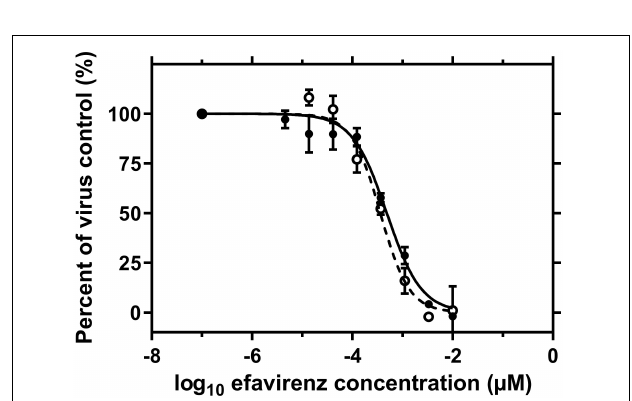
FIGURE 3 | No influence of the graphene ink on the dose-dependent antiviral activity of efavirenz in a cell-based HIV replication assay. An 8-point half-logarithmic serial dilution of efavirenz, starting from 0.01 µ M, was preincubated for 24 h with (a solid line) or without (a dashed line) graphene ink on PET-foil before use in a standard antiviral assay. The preincubation of efavirenz with graphene did not change the EC50 value of approximately 0.4 nM nor the overall characteristics of the dose-response curve. Error bars represent the standard deviation of triplicate